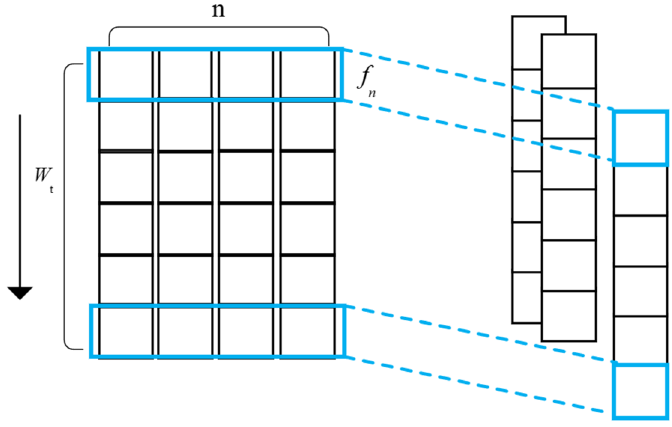
Figure 2. Schematic diagram of the 1D CNN structure.